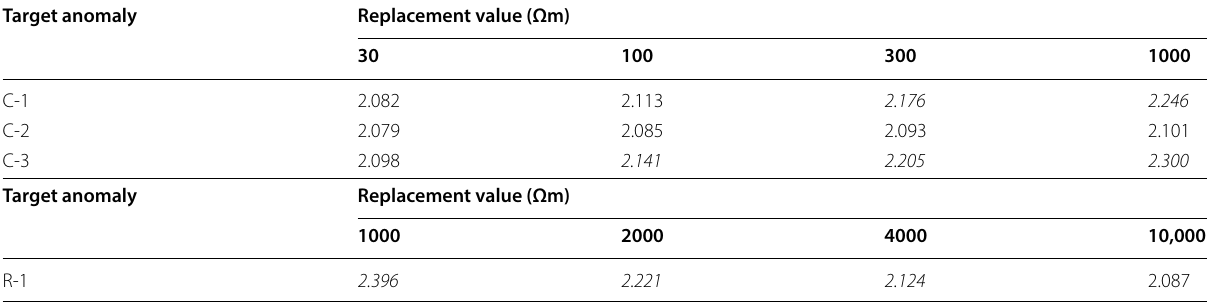
For target anomalies named with a leading “R” (or “C”), only the blocks with higher (or lower) resistivities than that shown in the “Replaced value” column were replaced. Italic RMS misfits indicate a model significantly different from the inverted model. The RMS misfit for the final inverted model was 2.082, and all models have 7296 degrees of